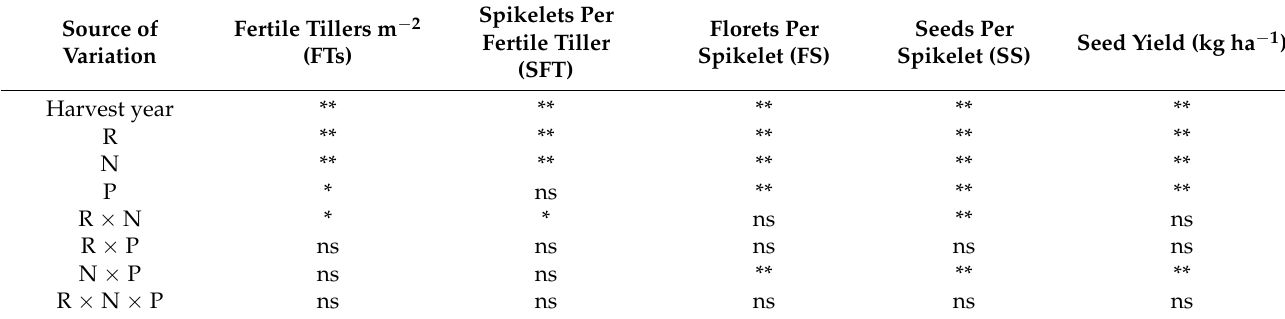
Table 1. ANOVA results for harvested year, row spacing, and N/P application on seed yield and seed yield components in smooth bromegrass. Source